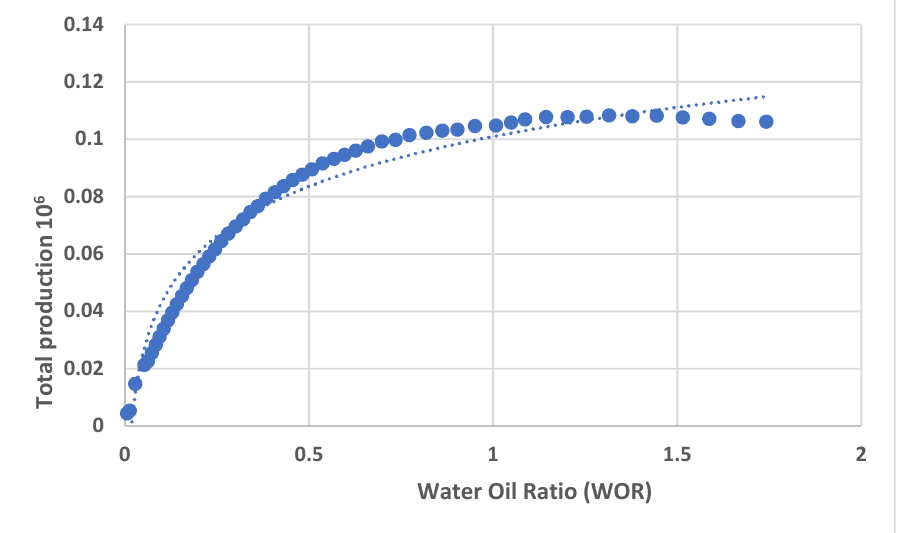
Figure 17. Water–oil ratio (WOR) versus static pressure.